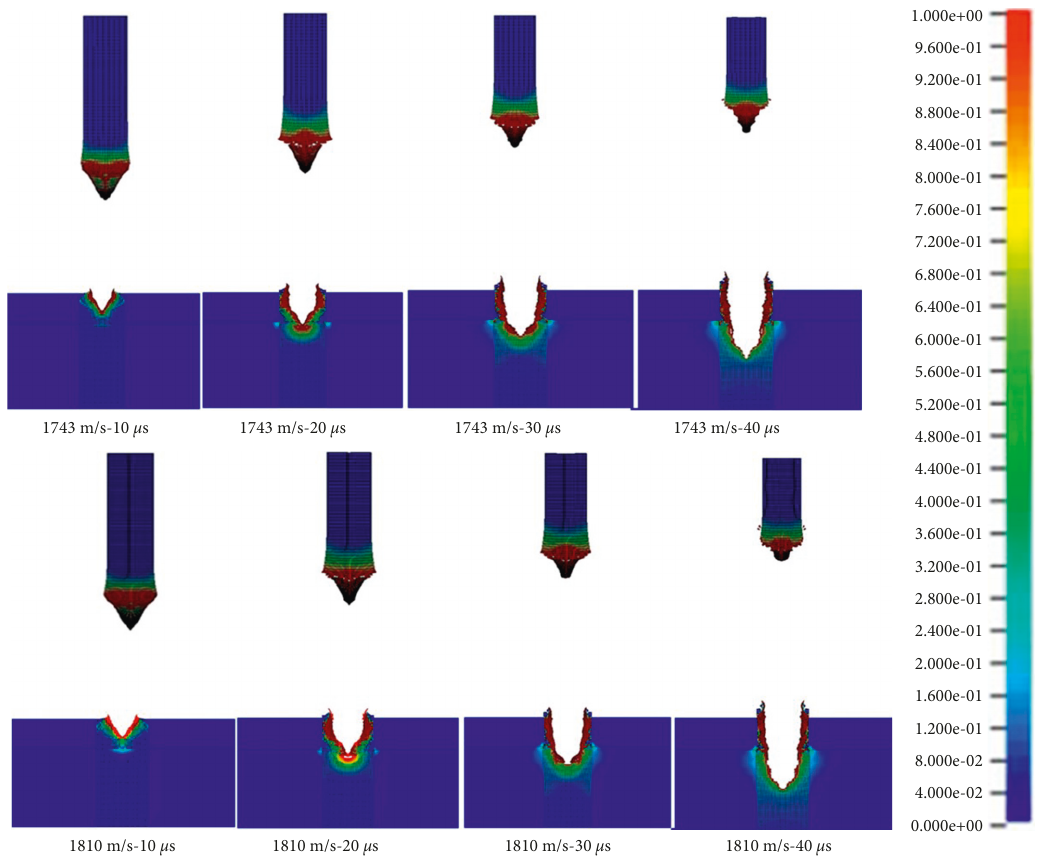
Figure 12: Changes in the shape of the